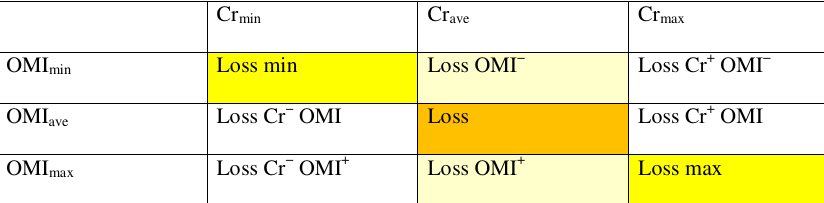
Table 6 Parameters and results of sensitivity analysis in the loss assessment (a) Different combinations of the minimum (−), average, and maximum ( + ) values of the parameters cost ratio and OMI data considered in the sensitivity analysis Cr min Cr ave Cr max